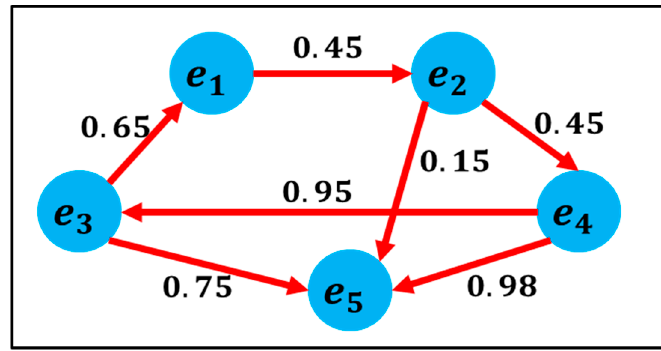
Figure 28. An example of the experts’ influence network (Ref. [117]).